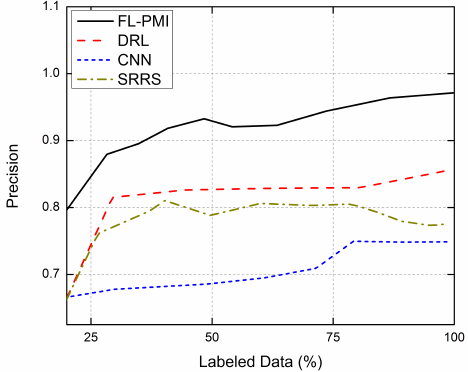
Figure 4. Analysis of auto-labelling in terms of precision.